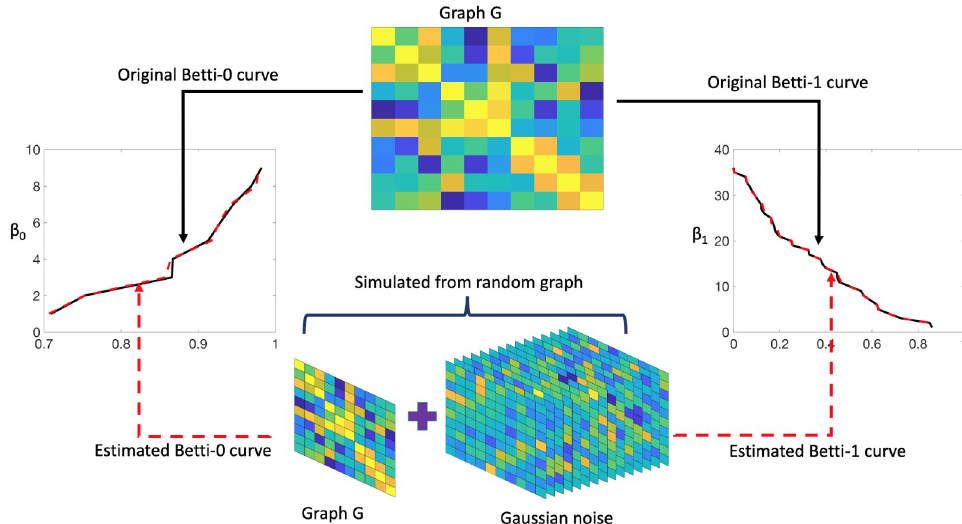
Fig 4. Schematic of validate the proposed method to compute expected birth and death values. The ground truth graph G is we used to calculate the Betti curves (solid black line) using the birth-death decomposition. We added Gaussian noise to edge weights to generate samples in each group. Then, we apply the proposed method on this set of sampled graphs and estimate the expected birth and death values and the Betti curves (dotted red line).